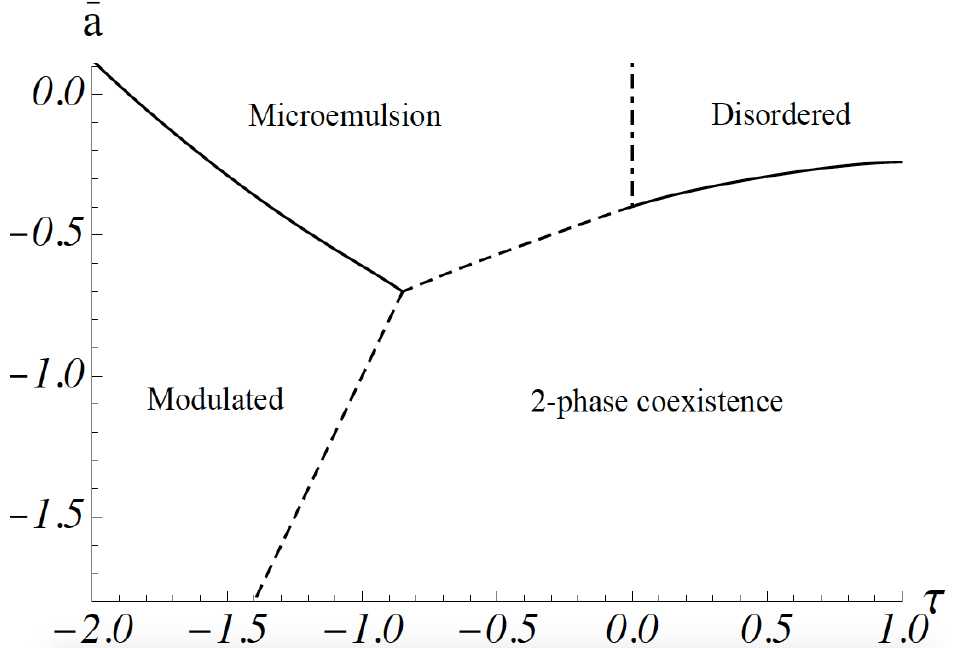
Figure 1. Phase diagram of the model. The dimensionless parameter ¯ a = a / c is proportional to the difference between the actual temperature and the compositionally-dependent transition temperature. τ is equal to [ b / ( cg ) 1/2 ]( 1 − κ 2 H 2 / b σ ) . First-order transitions are shown with dashed 0 lines. The Lifshitz line is shown at τ = 0. After reference